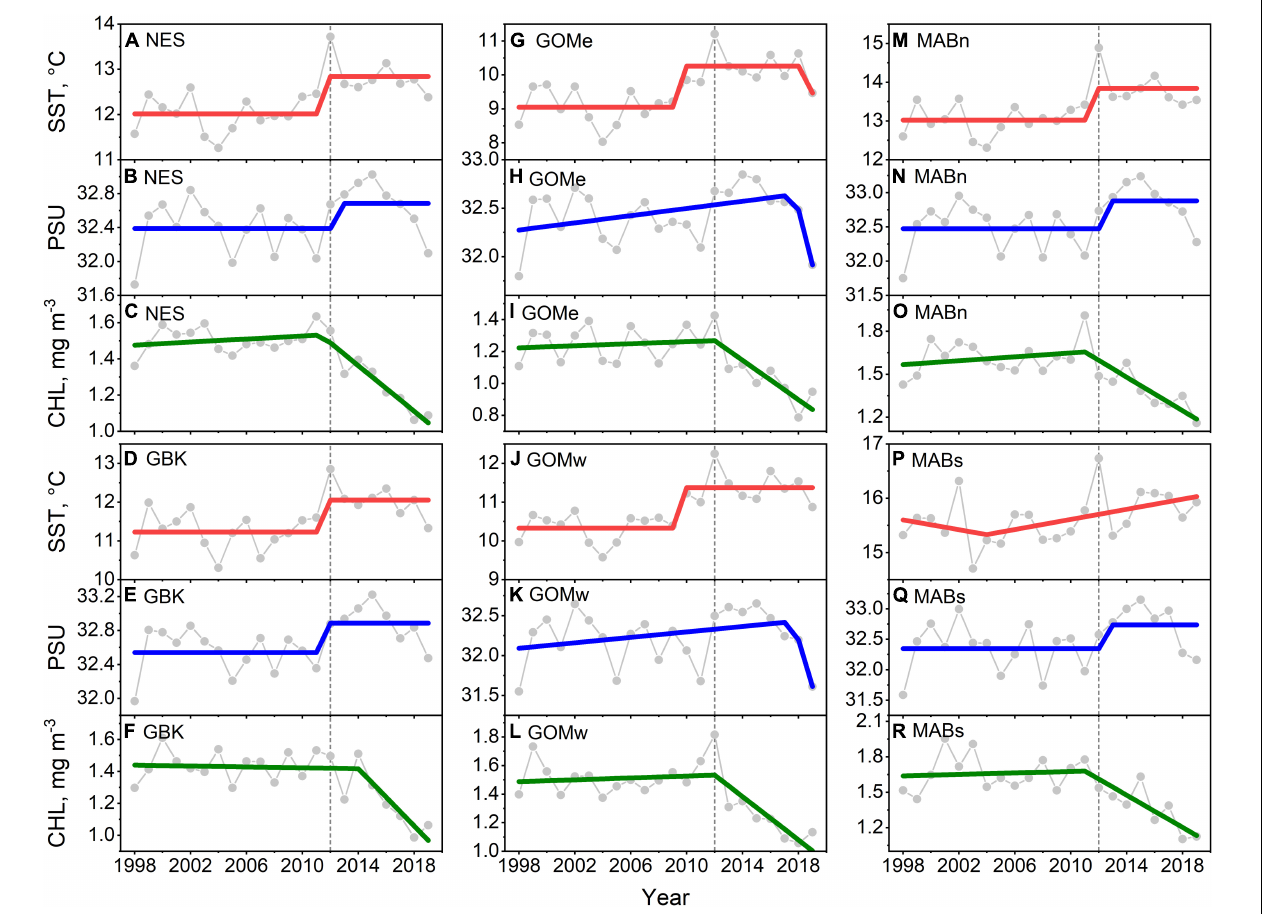
FIGURE 2 | Mean annual SST (A,D,G,J,M,P) for the Northeast Shelf (NES) and NES subareas (NES, GBK, GOMe, GOMw, MABn, and MABs, respectively), mean annual PSU (B,E,H,K,N,Q) and mean annual CHL (C,F,I,L,O,R) for the same areas, respectively. Lines are either STARS or segmented regression model fits; 2012 is highlighted with vertical dotted